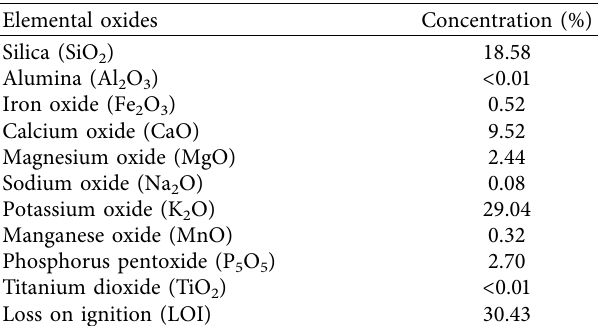
Table 2: Chemical properties of Enset